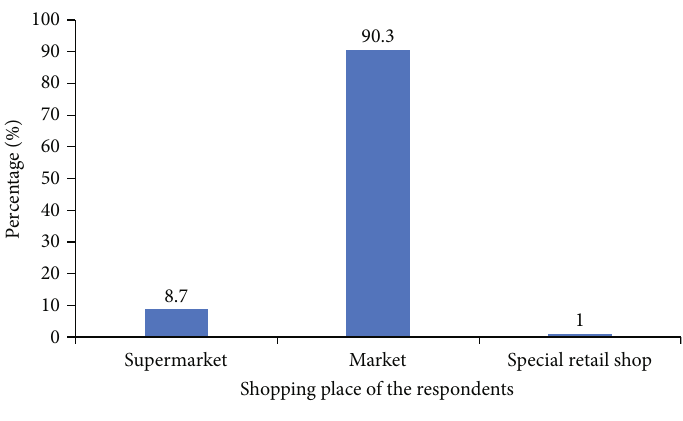
Figure 2: Shopping place of the